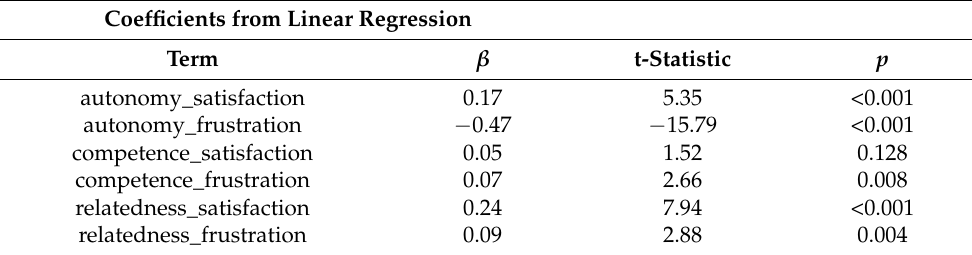
Table 4. Linear regression of the three psychological needs and willingness to get vaccinated. Coefficients from Linear